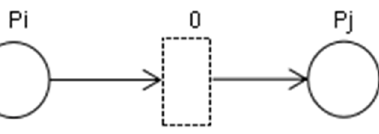
Figure 3. Probabilistic variation rule (T H i < X i < γ T H i ).